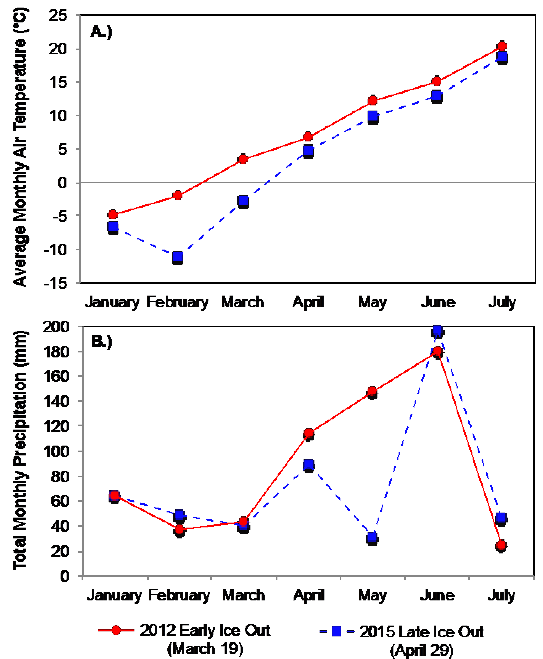
Figure 6. Boreal ( A ) average monthly air temperature in °C and ( B ) total monthly precipitation in mm for early and late ice-out years.